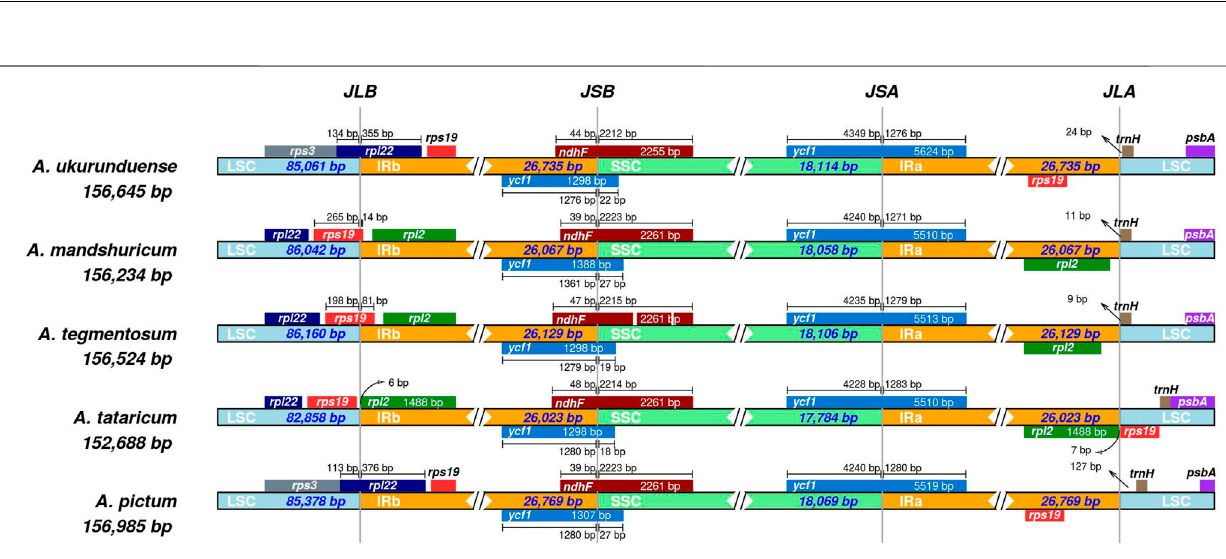
FIGURE 5 | Comparison of the junctions of LSC, SSC, and IR regions among fi ve cp genomes.